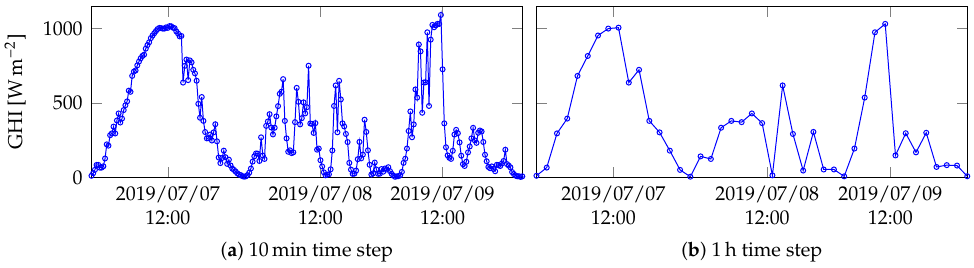
Figure 1. Difference in GHI dynamics between 10min and 1h time steps. Measurements are taken at PROMES-CNRS laboratory, located in Odeillo-Font-Romeu (Occitania region, southern